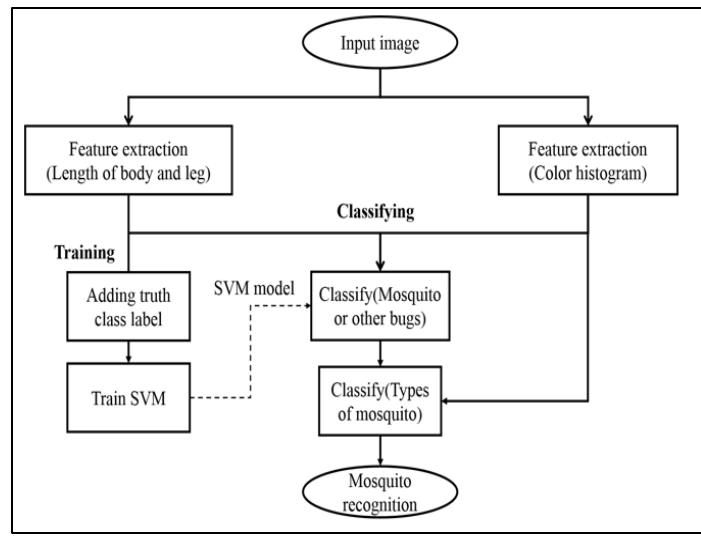
Figure 1. The schematic system architecture diagram of the proposed mosquito classification system.